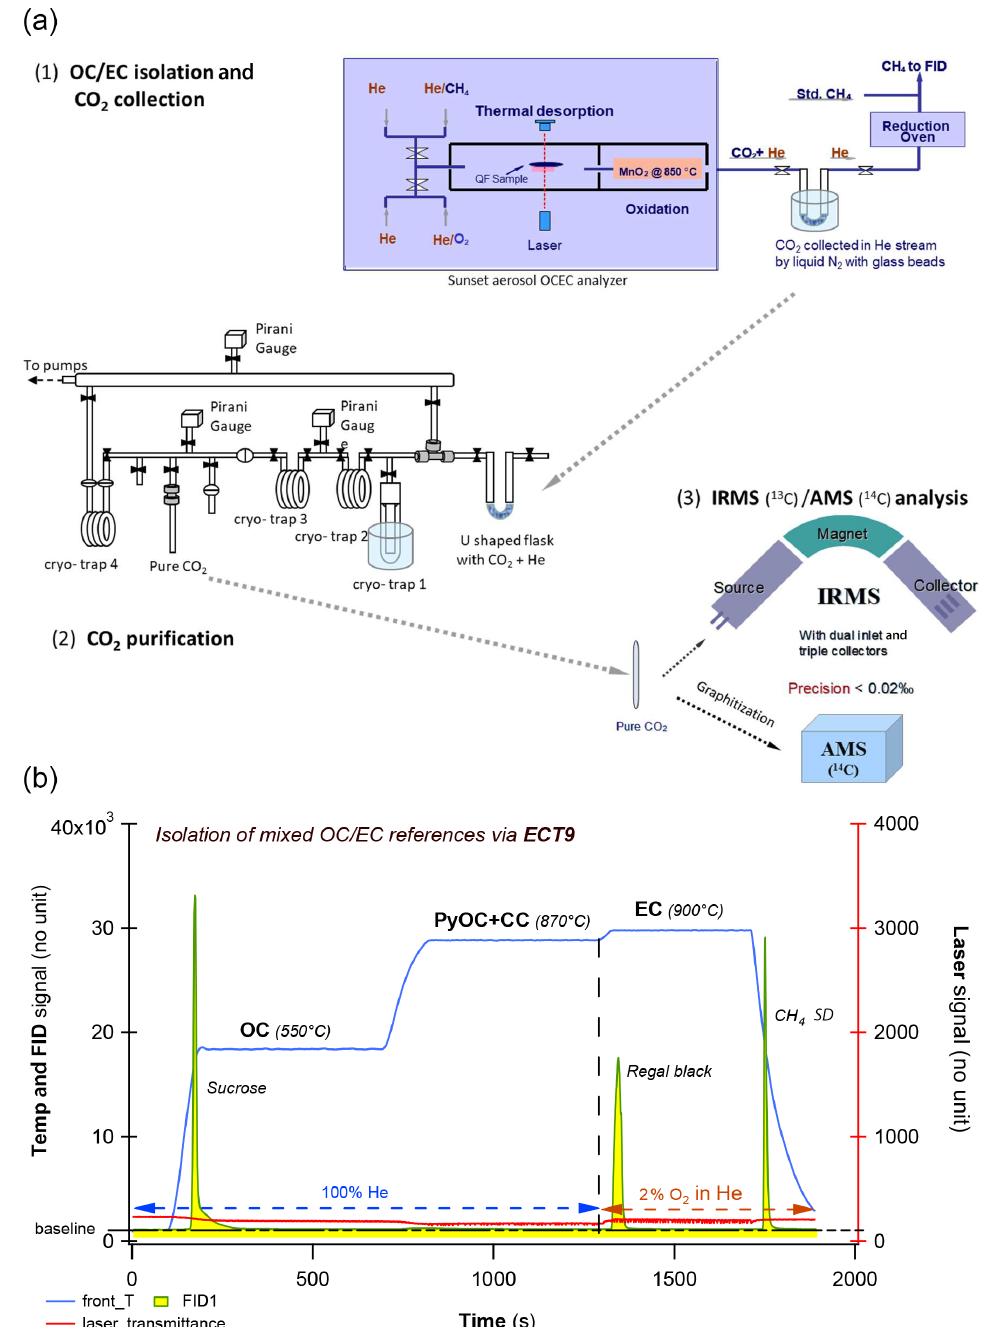
Figure 1. Overview of the carbonaceous aerosol measurements (concentration and isotopes) via EnCan-Totol-900 (ECT9). (a) Schematic procedures for 13 C and 14 C measurements of OC / EC via ECT9, including (1) OC / EC isolation and CO 2 collection via cryo-trapping, (2) CO 2 purification, and (3) isotope analysis with IRMS ( 13 C / 12 C of CO 2 ) or AMS ( 13 C / 12 C and 14 C / 12 C of graphite targets). (b) Ther- mogram of the ECT9 protocol on a Sunset OC / EC analyzer. First, organic carbon (OC) is thermally desorbed at 550 ◦ C for 600s in 100% He, and then any pyrolyzed OC (PyOC), refractory OC, and carbonate carbon (CC) is released at 870 ◦ C in 100% He for 600s. Finally, elemental carbon (EC) is combusted at 900 ◦ C for 420s by introducing 2% O 2 in He. All carbon fractions are oxidized to CO 2 followed by reduction to CH 4 and quantification via flame ionization detection (FID) for carbon content or purified and cryo-trapped in Pyrex ampoules for isotope analysis. Example FID signals are shown for a pure OC reference material (sucrose) mixed with a pure EC material (regal black) and the internal standard (CH 4